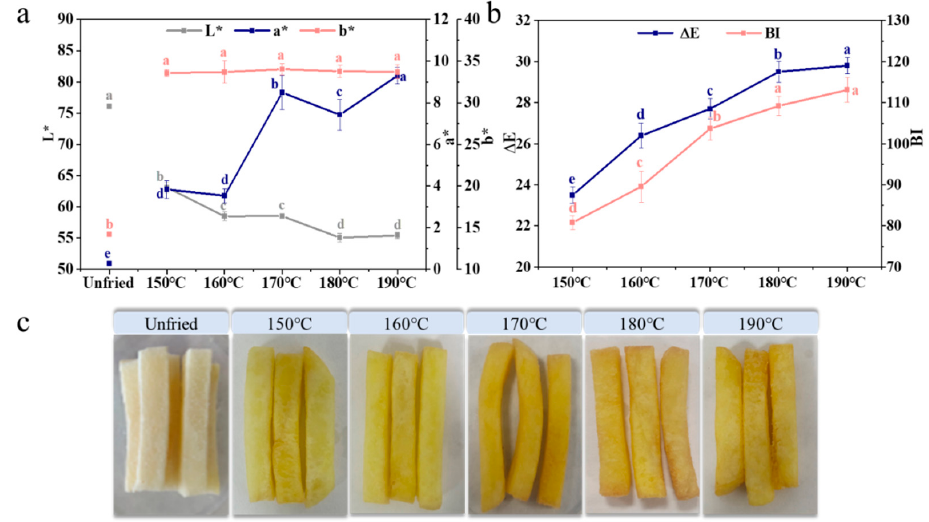
Figure 6. Effect of frying temperature on the color ( a , b ) and appearance ( c ) of French fries. Different letters (a – e) indicate significant differences ( p ≤ 0.05).